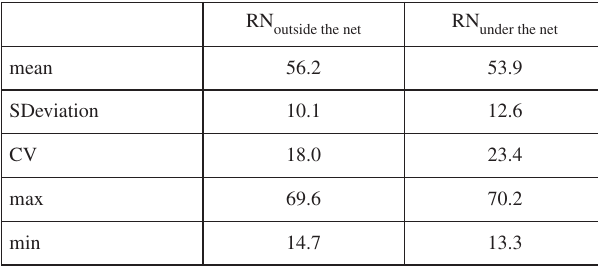
Table 2. The statistical parameters of daily amplitude of relative air humidity measured under the hail protection net and outside of it /Pallag 2011 June 1 – September